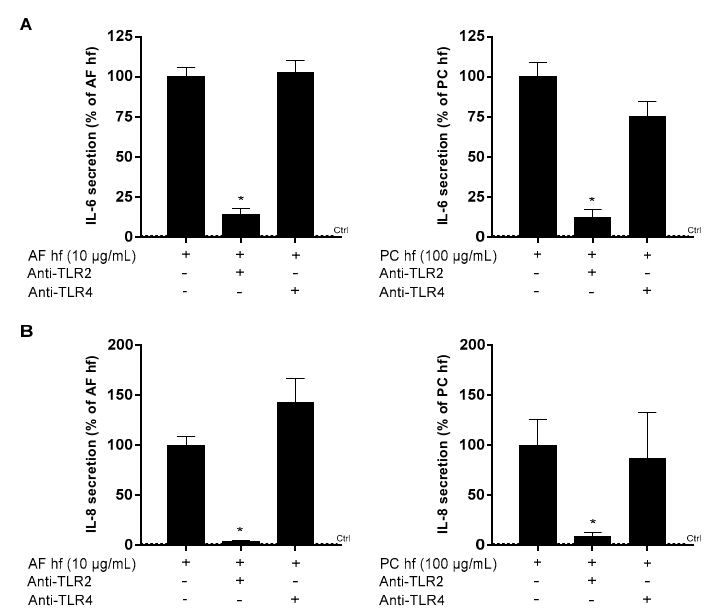
Figure 5. Inhibition of A. fumigatus - or P. chrysogenum -induced IL-6 and IL-8 release by attenuating TLR2 and TLR4. BEAS-2B cells were pretreated with human TLR2 blocking antibody MAB2616 (0.2 µ g/mL) or TLR4 antagonist AF1478 (10 µ g/mL) for one h and further incubated with X-ray treated hyphal fragments (hf) of A. fumigatus (AF; 10 µ g dry weight/mL) or P. chrysogenum (PC; 100 µ g dry weight/mL) for 6 h. Medium blanks were included as control. Release of ( A ) IL-6 and ( B ) IL-8 were assessed by ELISA. Bars represent mean ± SEM of three independent experiments. Statistical analyses were performed by two-way ANOVA with Dunnett’s post-tests on 2-step normalized data. Significant difference compared to the respective hyphal fragments denoted by * p < 0.05. Int. J. Environ. Res. Public Health 2019 , 16 , x